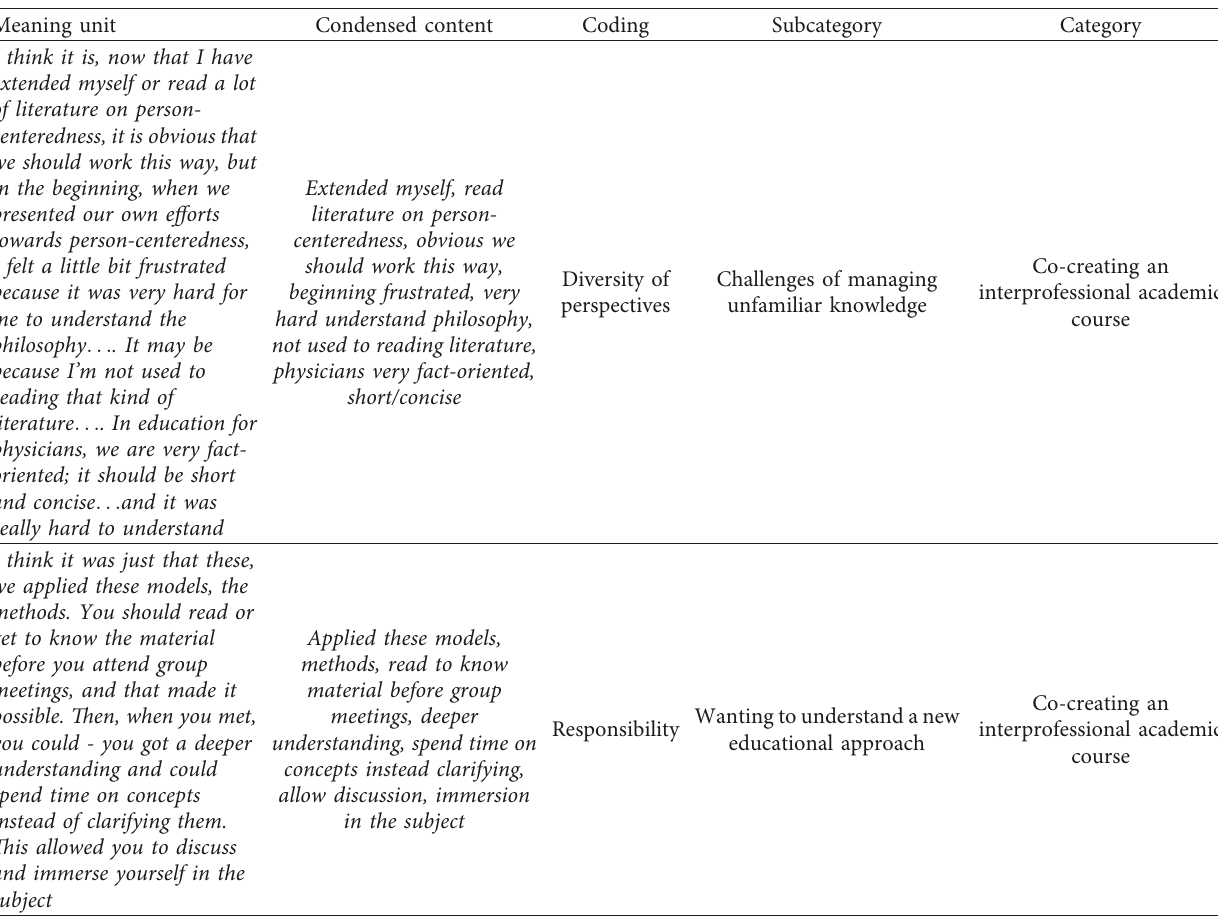
Table 1: Example of content analysis of content into subcategories that formed a